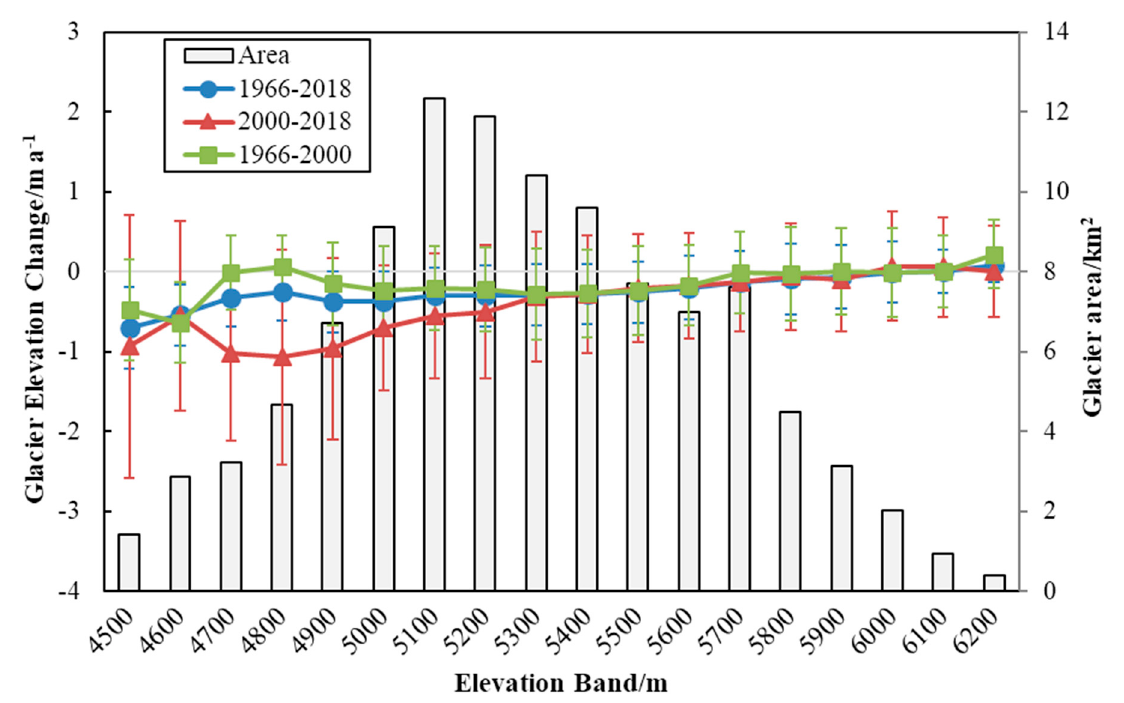
Figure 5. Average surface elevation changes in the glaciers over the A'nyêmaqên Mountains from 1966 to 2018. (Error bars are the STD values on the DEM differencing on each 100 m elevation bin). The grey bars indicate the distribution of each 100 m elevation bin glacier area for the glaciers in 2000.